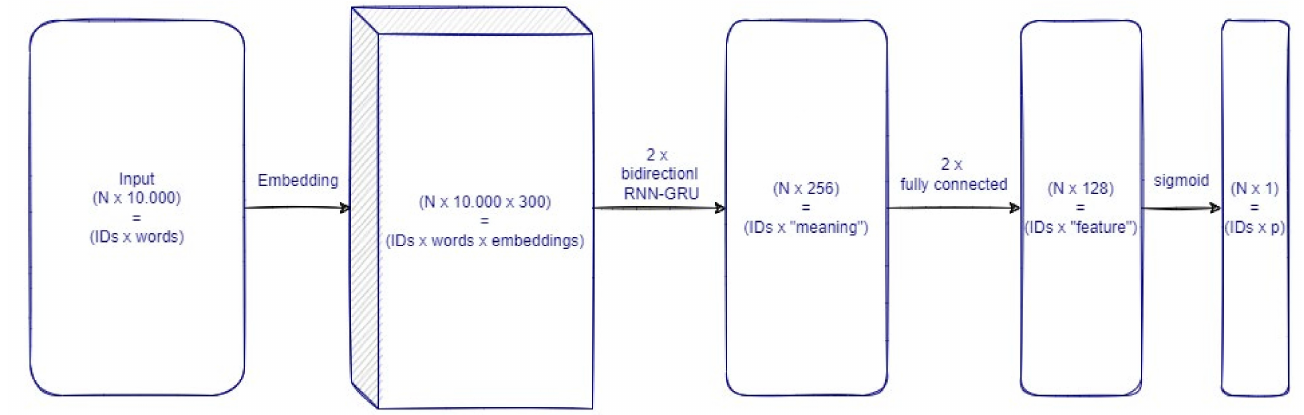
Figure 2. Flowchart of the trained network. The boxes report shapes and shape interpretation of the data between each computation step, i.e., between layers of the network. Layers are reported as linking connections between the boxes. N represents the size of the record passed in input; for our minibatch training, N is 16; for overall records, N depends on the set reported in Table